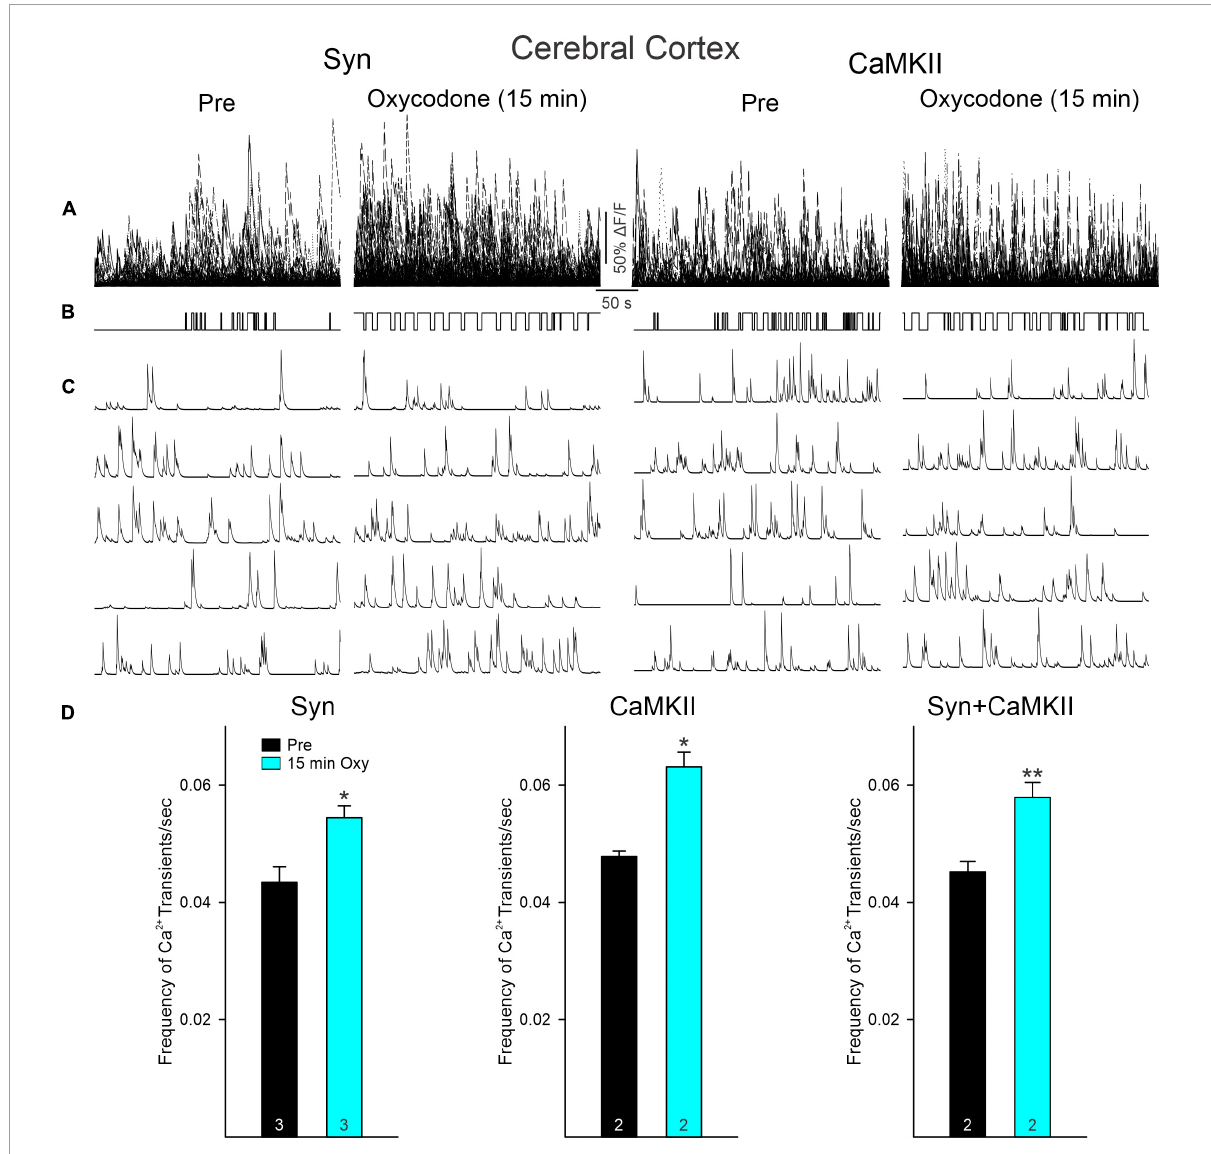
FIGURE5 (A) Traces represent multi-neuronal Ca 2 + transients recorded in the cortex (layers II/III) of mice with viral injections of GCaMP6f expressed using Syn or CaMKII promoters before and 15 min after oxycodone. Each trace represents the activity of 1 neuron. Notice that, in contrast to striatum, the number of active cells was not reduced after oxycodone. (B) Upward deflections indicate the mouse was moving. As shown in the previous figure, in control conditions the behavior was random, whereas after oxycodone it became more stereotyped. (C) Representative Ca 2 + transient traces of single cortical pyramidal neurons (CPNs). After oxycodone, Ca 2 + transient frequency increased. (D) Graphs show changes in frequency of Ca 2 + transients before and after injection of oxycodone in CPNs. Cells from Syn and CaMKII mice increased their frequency